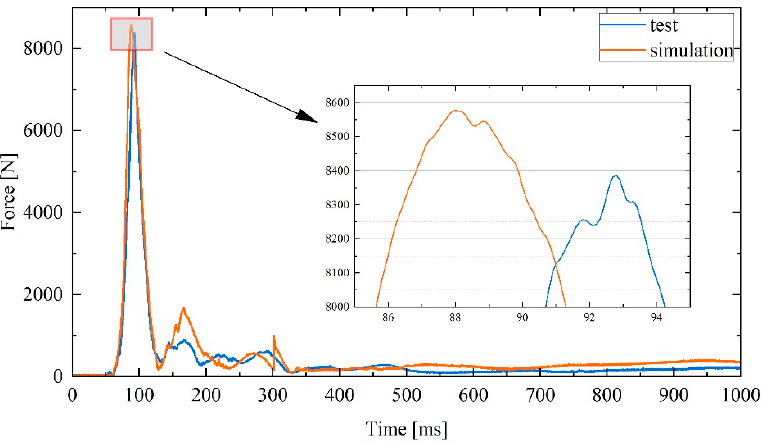
Figure 8. Spine load–time curve during the crash. The arrow indicates the change of the spine load during a short time when the peaks of the test and the simulation occur, respectively.